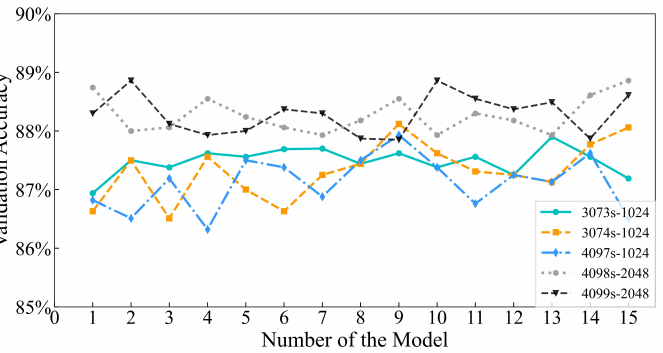
Figure 8. Validation accuracy of each model with different hand-crafted feature inputs (such as the legend of 3073 s-1024: a truncation length of 30.73 s is used in the preprocessing, and the first dimension of hand-crafted features is